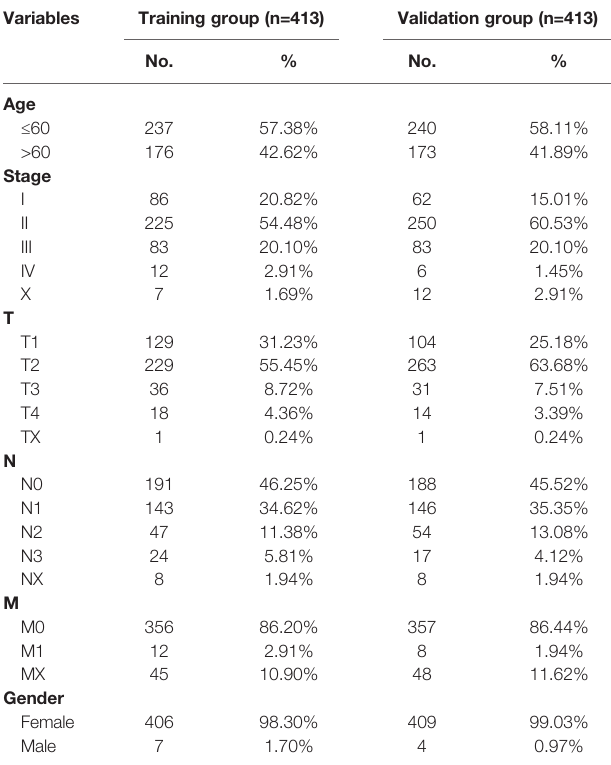
TABLE 1 | Clinical characteristic of patients in the training and validation groups. Variables Training group